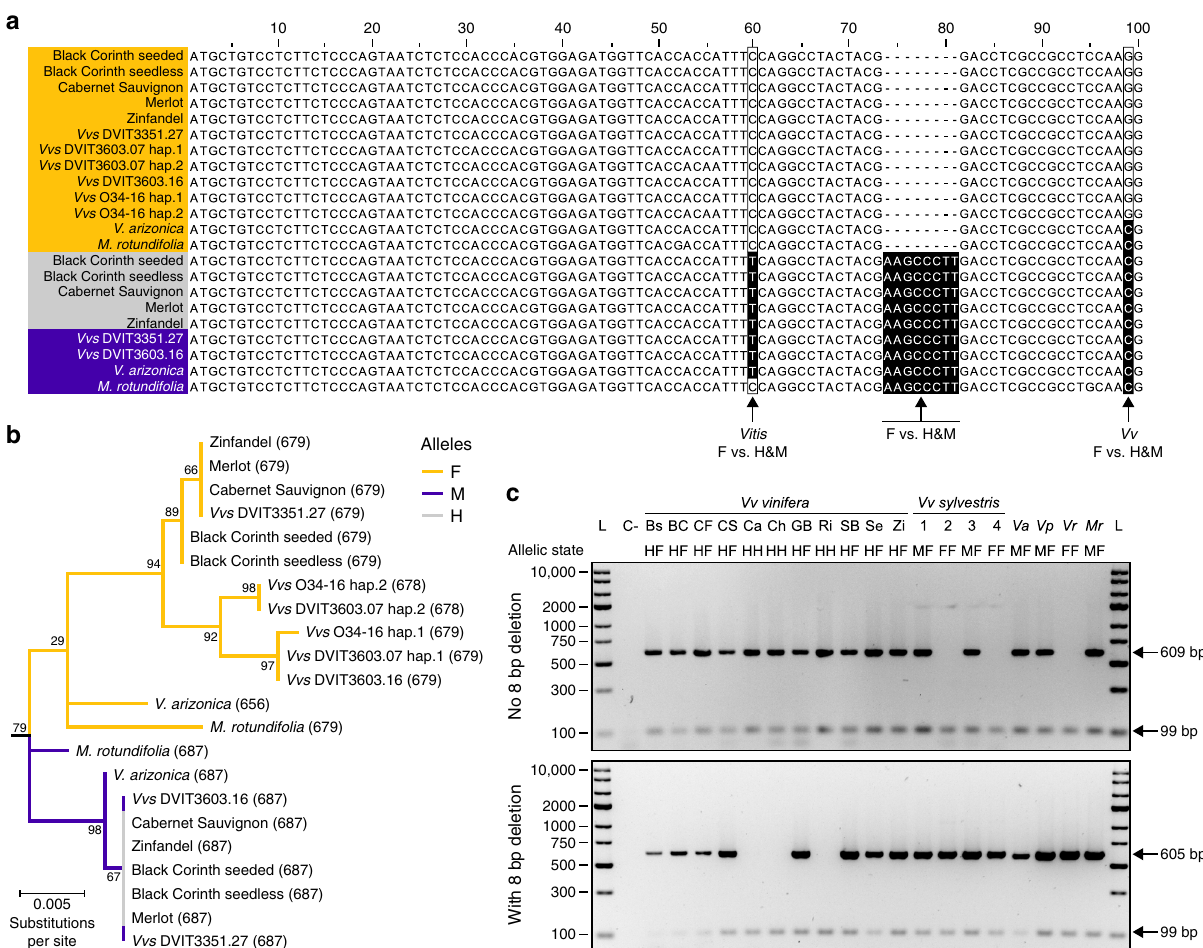
Fig. 4 Mutations and segregation in VviINP1 . a Alignment of the fi rst 100 bp of 20 VviINP1 coding sequences representing 12 F, 5 H and 3 M haplotypes along with two M. rotundifolia INP1 coding sequences from F and M haplotypes. Alignment revealed an F-linked 8 bp INDEL in VviINP1 throughout Vitis and shared with M. rotundifolia . Yellow, purple and gray colors represent F, M and H haplotypes, respectively. b Phylogenetic subtree of the INP1 coding sequences from Vitis spp. and M. rotundifolia . The tree was rooted with INP1 sequences from seven outgroups (see “ Methods ” ). Tree branches are colored according to sex-determining region haplotype. Scale bar is in the unit of the number of substitutions per site. Sequence length in bp is indicated in parentheses. c Marker assay amplifying INP1 fragment without (top panel, 609 bp) or with (bottom panel, 605 bp) the 8 bp deletion. Actin was used as a PCR positive control (99 bp fragment). This assay was performed three times. Vvs Vv sylvestris , L Ladder, C − negative control, Vv vinifera : Bs seeded Black Corinth, BC seedlees Black Corinth, CF Cabernet Franc, CS Cabernet Sauvignon, Ca Carménère, Ch Chardonnay, GB Gouais blanc, Ri Riesling, SB Sauvignon blanc, Se Semillon, Zi Zinfandel, Vv sylvestris : 1, DVIT3351.27; 2, DVIT3603.07; 3, DVIT3603.16; 4, O34-16; Va V. arizonica , Vp V. piasezkii, Vr V. romanetii, Mr M. rotundifolia . Source data are provided as a Source Data fi